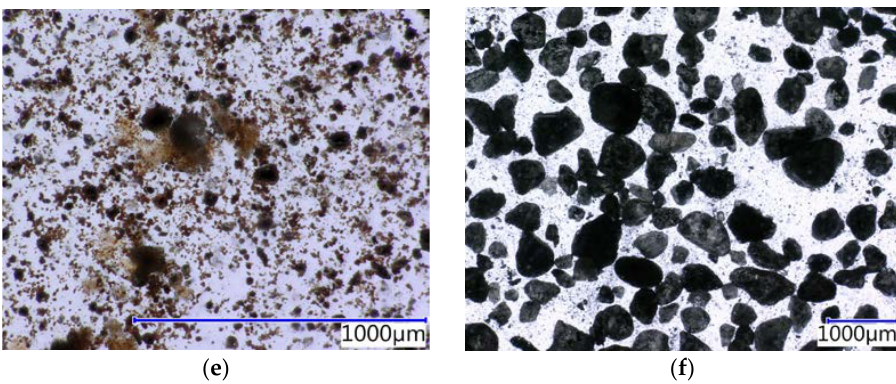
Figure 4. The structure of individual filler types: ( a ) REF—Silica sand (16×); ( b ) WGS—Waste glass from the QS solar panels (16×); ( c ) RGI—Recycle from the production of mineral glass insulation (67×); ( d ) FA—Fly ash (67×); ( e ) NS—Neutralisation sludge (67×); ( f ) WFS—Waste foundry sand (16×). Table 4. Basic properties of the fillers.